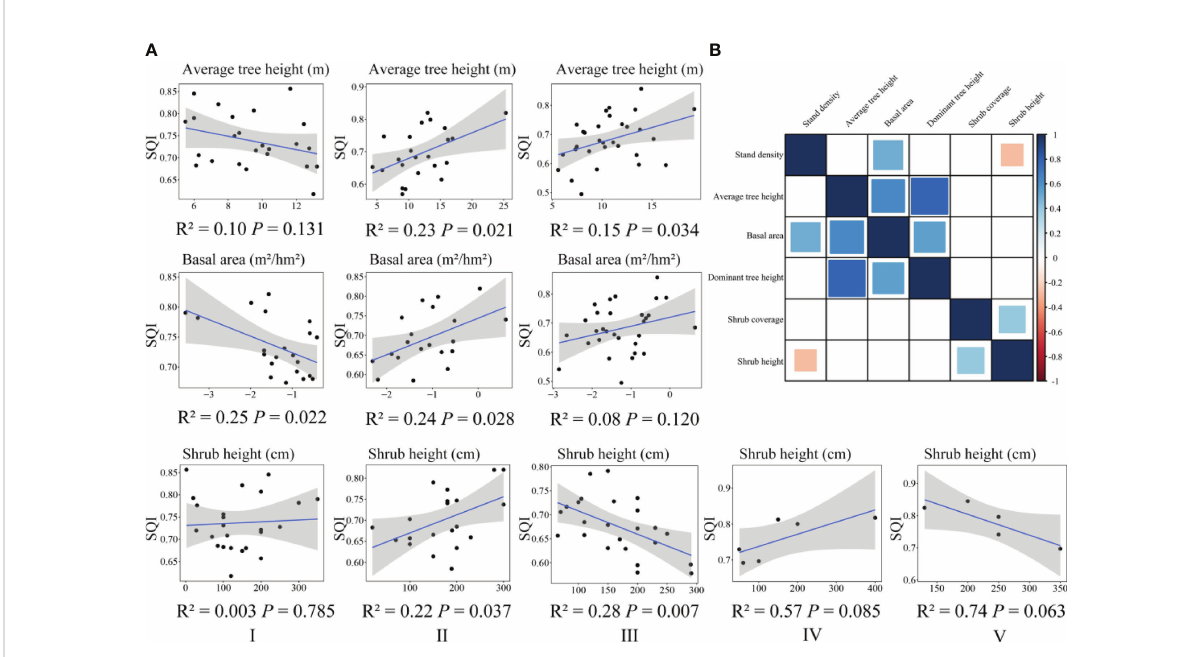
FIGURE 4 Correlation between soil quality and vegetation characteristics in different forest land types (A) . Correlation of aboveground vegetation characteristics of different forest types (B) . The blue square indicates that there is a signi fi cant positive correlation between indicators; the red square indicates that there is a signi fi cant negative correlation between indicators; the white square indicates that there is no signi fi cant correlation between indicators. I, broad- leaved forest; II, coniferous forest; III, mixed coniferous and broad-leaved forest; IV, bamboo forest; V, shrub